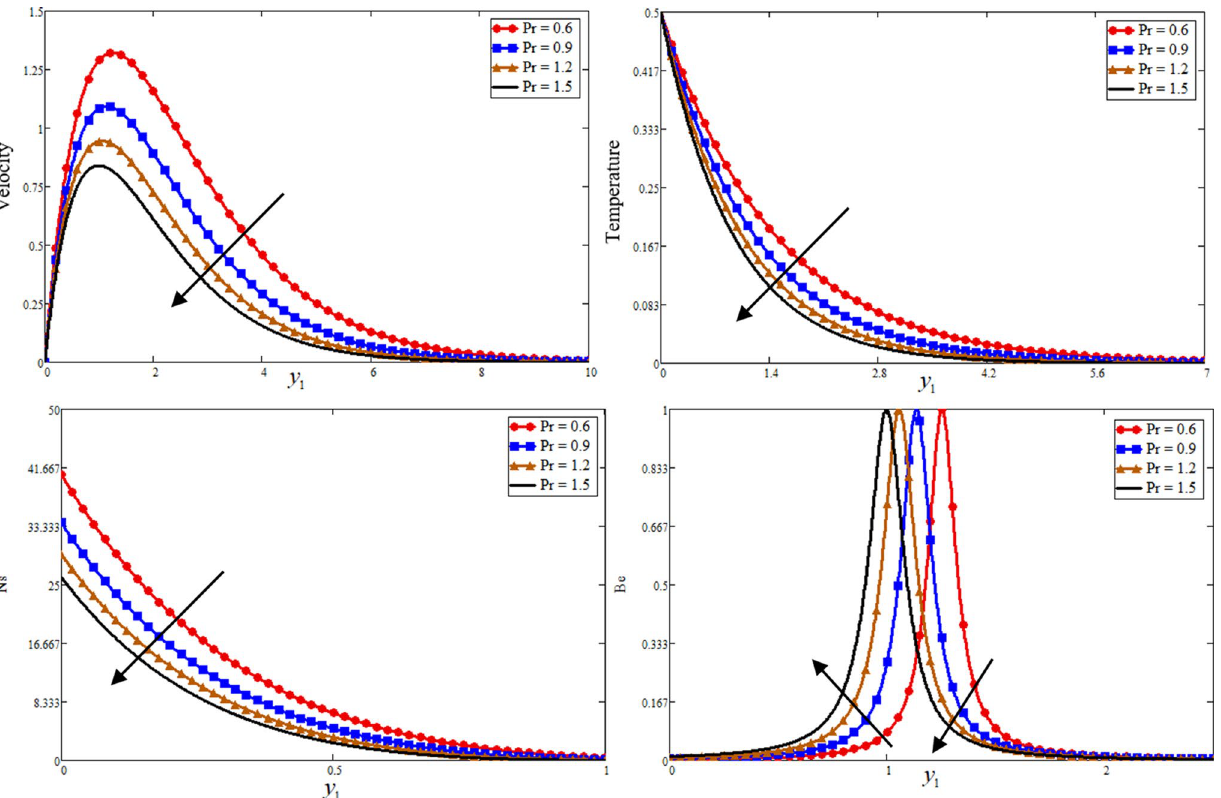
Figure 2. Effect of Pr Bejan number, entropy generation, temperature, and